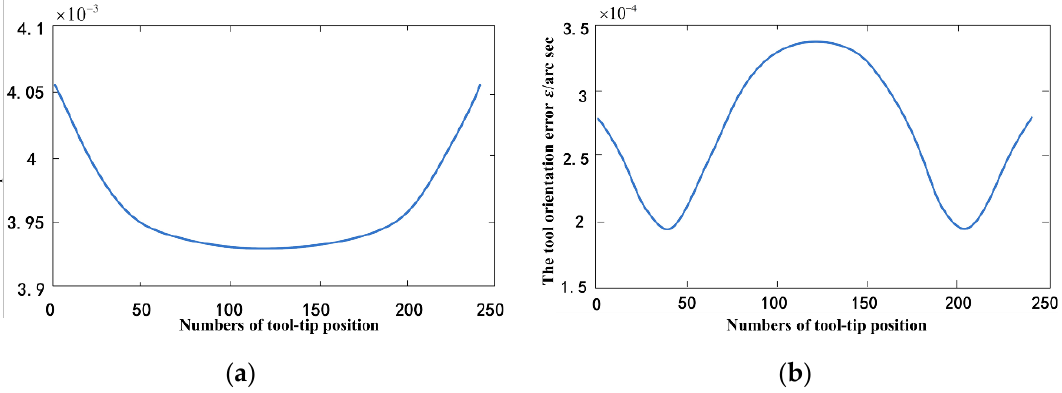
Figure 12. Deviation errors of tool − tip position and tool orientation. ( a ) Tool − tip position error. ( b ) Tool axis orientation error.